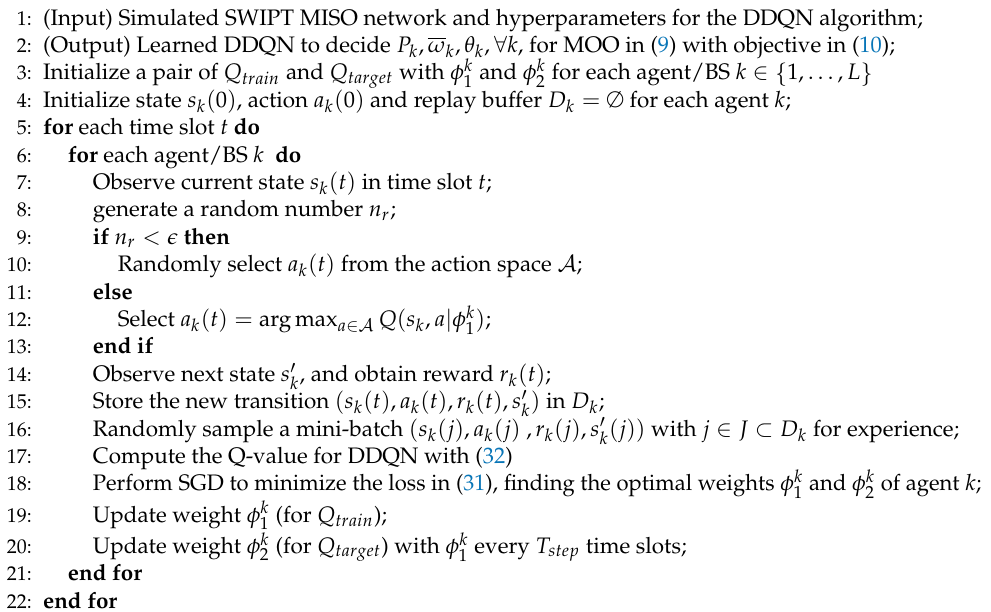
Algorithm 2 Multi-agent DDQN